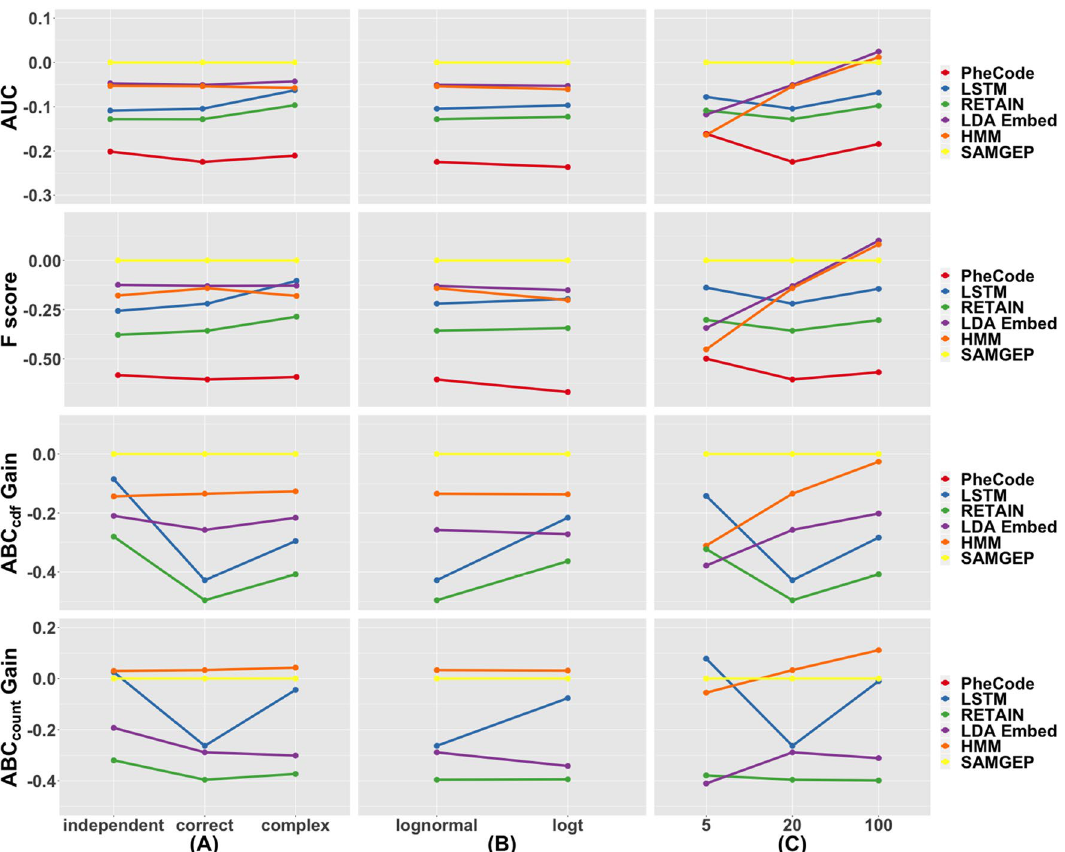
Figure 3. Robustness of SAMGEP and comparator methods’ AUCs, F scores, ABC cdf gains, and ABC count gains to various generative parameters, including the ( a ) specification of Y | T , ( b ) specification of C | Y , and ( c ) number of informative (i.e. non-sparse) features. Details of the experiments are delineated in the “Simulation study” subsection of the “Methods”, and more extensive results are displayed in Supplementary Fig.